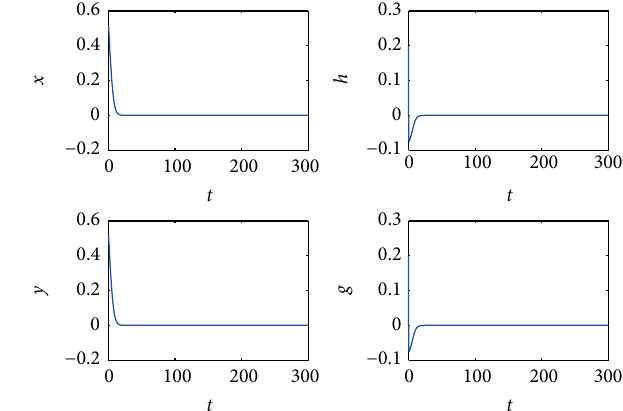
Figure 4: Simulated solution of Equation (20) for (𝜀